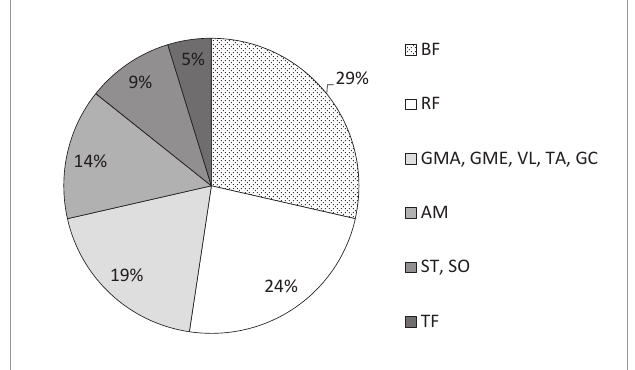
Figure 2. Relative frequency of muscles studied in included studies (AM: adductor magnus, BF: biceps femoris, GC: gastrocnemius, GMA: gluteus maximus, GME: gluteus medius, RF: rectus femoris, SO: soleus, ST: semitendinosis, TA: tibialis anterior, TF: tensor fasciae latae, VL: vastus